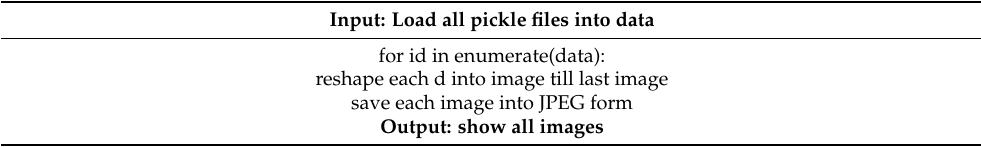
Table 1. The algorithm of turning pickles into JPEG